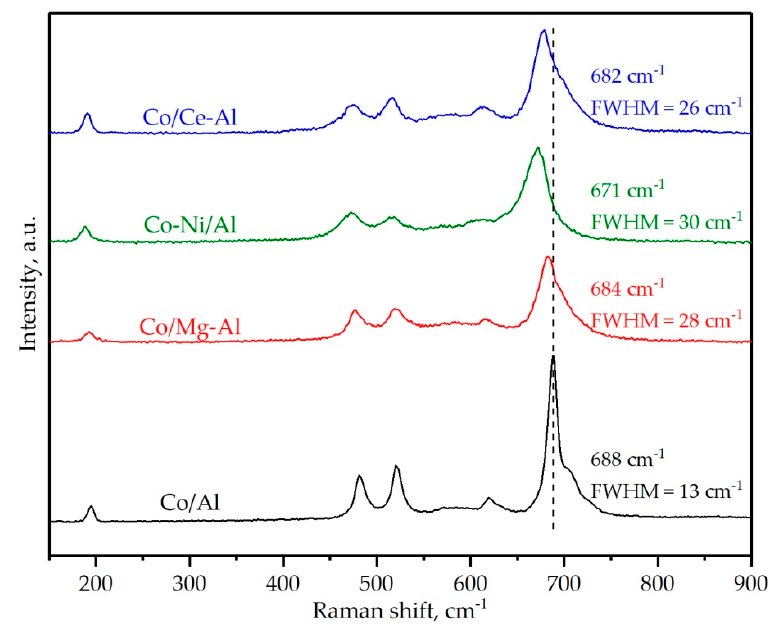
Figure 5. Raman spectra of the supported cobalt catalysts.